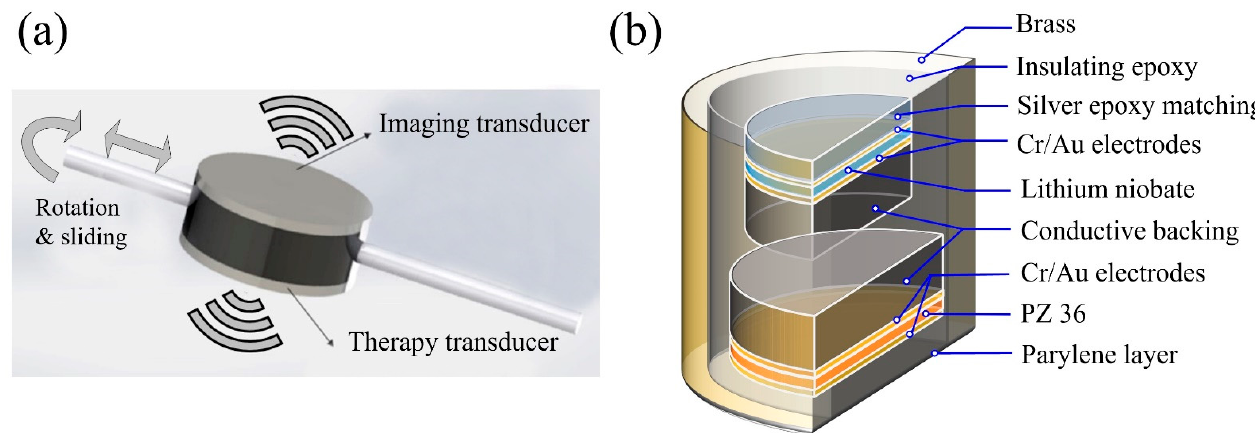
Figure 1. Back-to-back (BTB) dual-mode ultrasonic transducer for imaging and treatment; ( a ) the BTB structure was configured to have two modes—imaging and therapy; ( b ) internal construction of the BTB transducer.